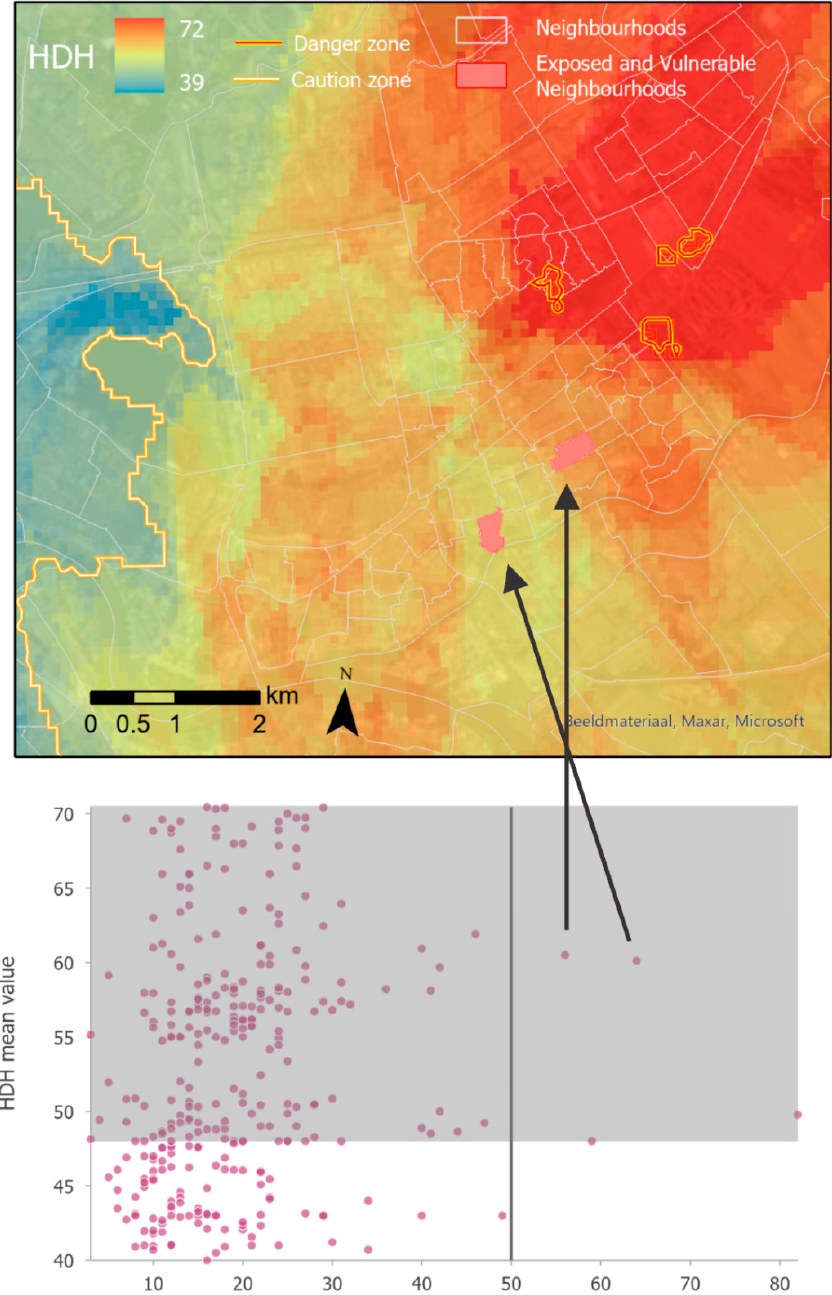
Figure 6. Two neighbourhoods with both high humidex degree hours (HDH) values and a high share of vulnerable population .